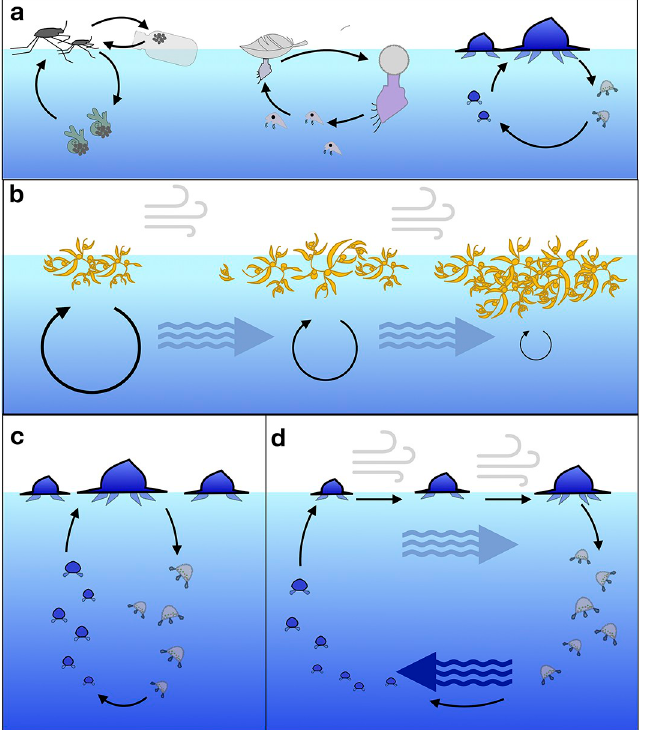
Fig 4. Possible life history mechanisms for localization and dispersal of neustonic organisms. (a) Some neustonic species lay eggs on floating objects and sometimes pelagic organisms (e.g., Halobates spp.), while others require surface floating objects for early life cycle stages (e.g., Dosima fascicularis [83]), still others may remain at or near the surface throughout a life cycle due to a dependence on endosymbiotic photosynthetic zooxanthellae (a hypothesis proposed by Larson for Velella [75]). (b) Neustonic organisms like Sargassum may proliferate in one region (large circle) and be transported by wind and/or currents to high-density regions of low proliferation (small circles) [25]. (c) Neuston may also occupy deep water for one part of their life history (a hypothesis proposed for Velella by Woltereck [84]), and (d) these deep-water habitats may allow them to take advantage of counter currents for transport in the direction opposite surface currents (a hypothesis proposed for Velella by Savilov